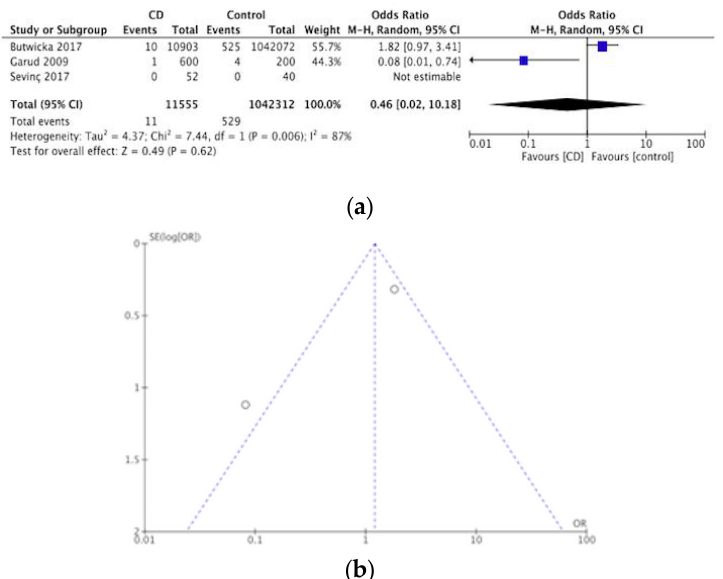
Figure 7. ( a ) Forest plot of pooled prevalence of schizophrenia and other psychotic disorders in CD. ( b ) Funnel plot investigating distribution in schizophrenia and other psychotic disorders studies.